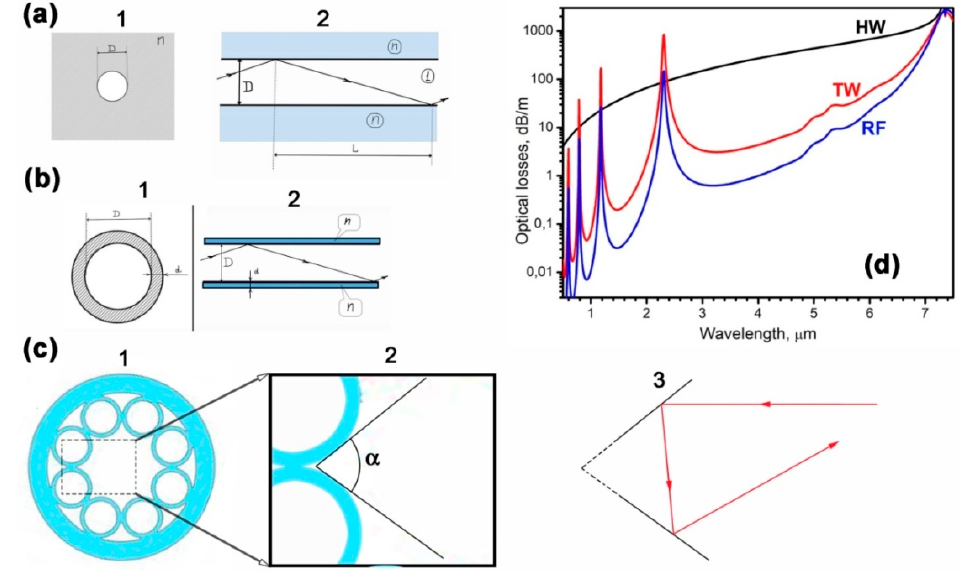
Figure 2. ( a ) Cross-(1) and longitudinal (2) sections of the hollow waveguide [10]; ( b ) Cross-(1) and longitudinal (2) sections of the tube waveguide [11]; ( c ) Cross-section (1) of the RF [1], approximation of